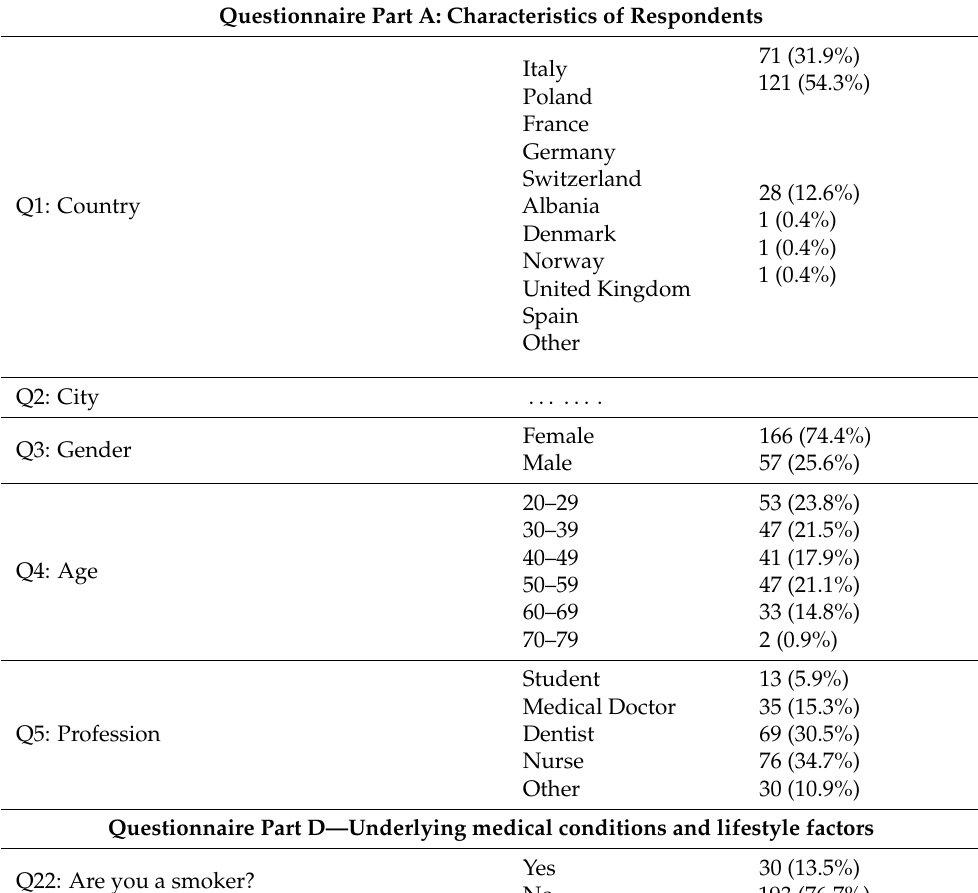
Table 1. Characteristics of the